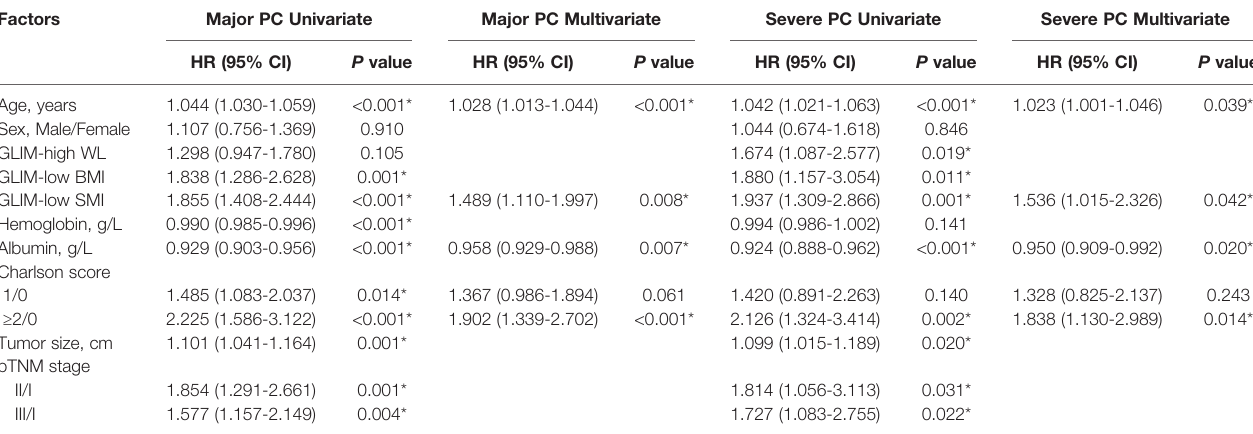
TABLE 3 | Univariate and multivariate logistic regression analysis for postoperative complications in the entire cohort. Factors